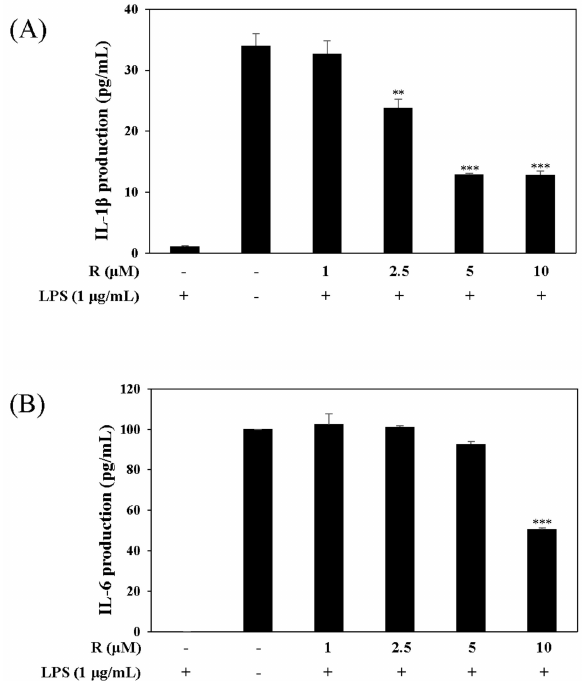
Figure 6. E ff ect of R on the expression of proinflammatory cytokines, IL-1 β and IL-6. RAW 264.7 cells were pretreated with R for 1 h, then incubated with LPS (1 µ g / mL) for 16 h. The levels of IL-1 β ( A ) and IL-6 ( B ) in culture media were measured by ELISA. The data are represented as the mean ± SD. * p < 0.05, ** p < 0.01, *** p < 0.001 vs. LPS-treated